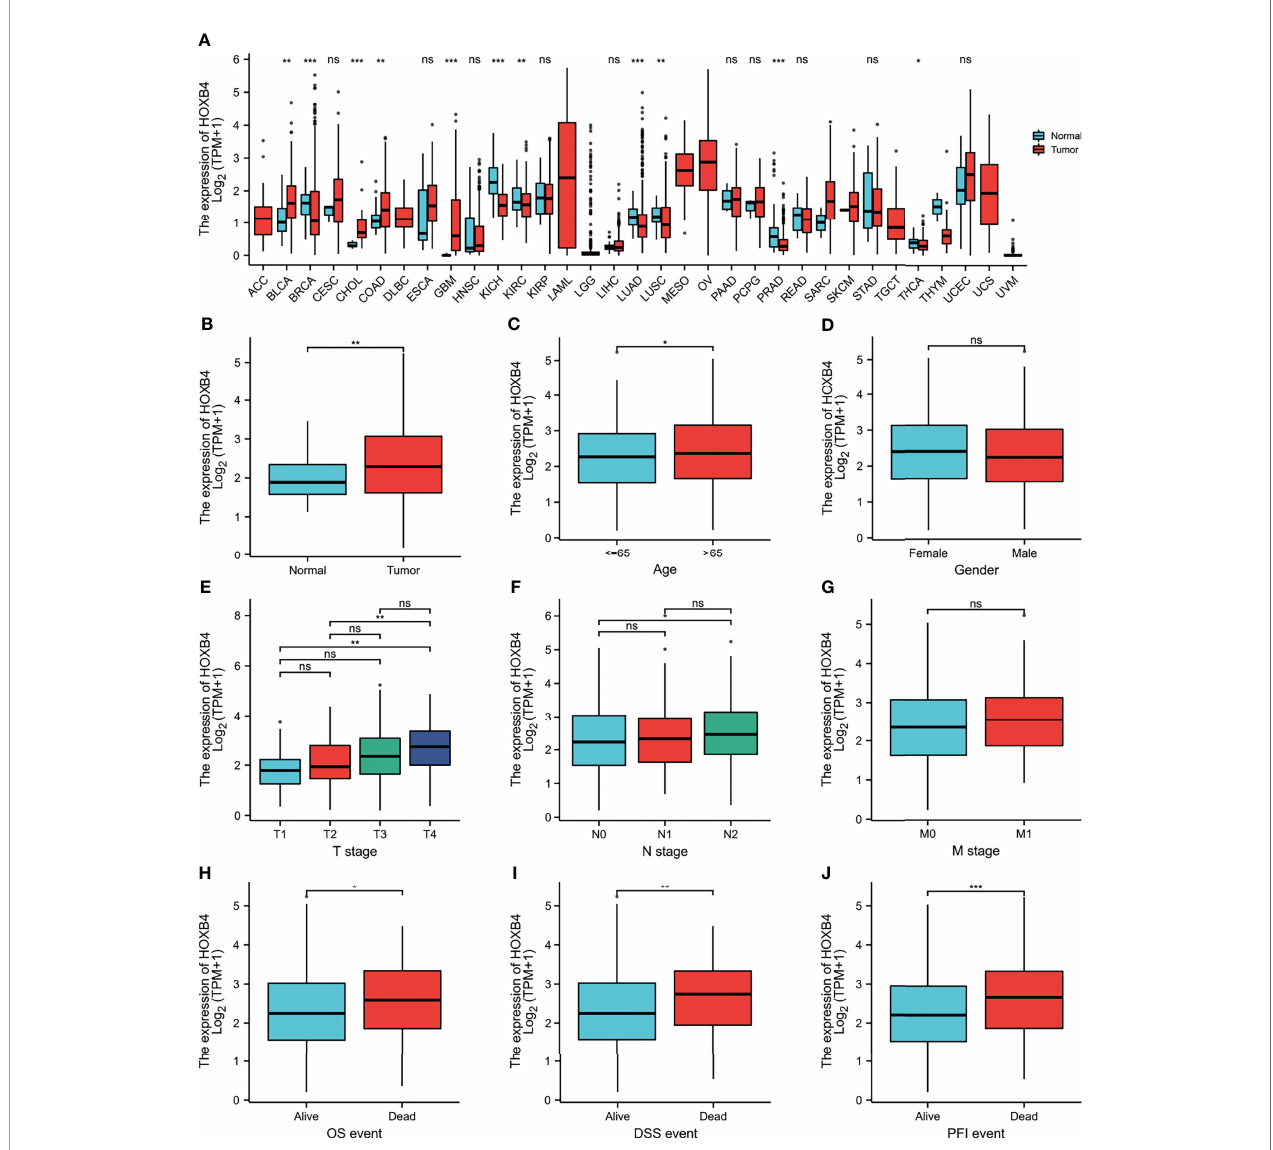
FIGURE 2 | The mRNA expression levels of HOXB4 in cancers. (A) The HOXB4 mRNA expression in different cancers or in colon adenocarcinoma. (B) HOXB4 expression level in colorectal cancer tissue and normal tissue from TCGA dataset. (C – G) HOXB4 expression level in age, gender, different T stages, different N stages and different N stages in COAD. (H – J) HOXB4 expression level in COAD with OS event, DFS event, and PFI event. * P <0.05; ** P <0.01; *** P <0.001 were considered statistically signi fi cant. OS, overall survival; DFS, disease-speci fi c survival; PFI, progression free interval; COAD, colon adenocarcinoma; ns, no signi fi